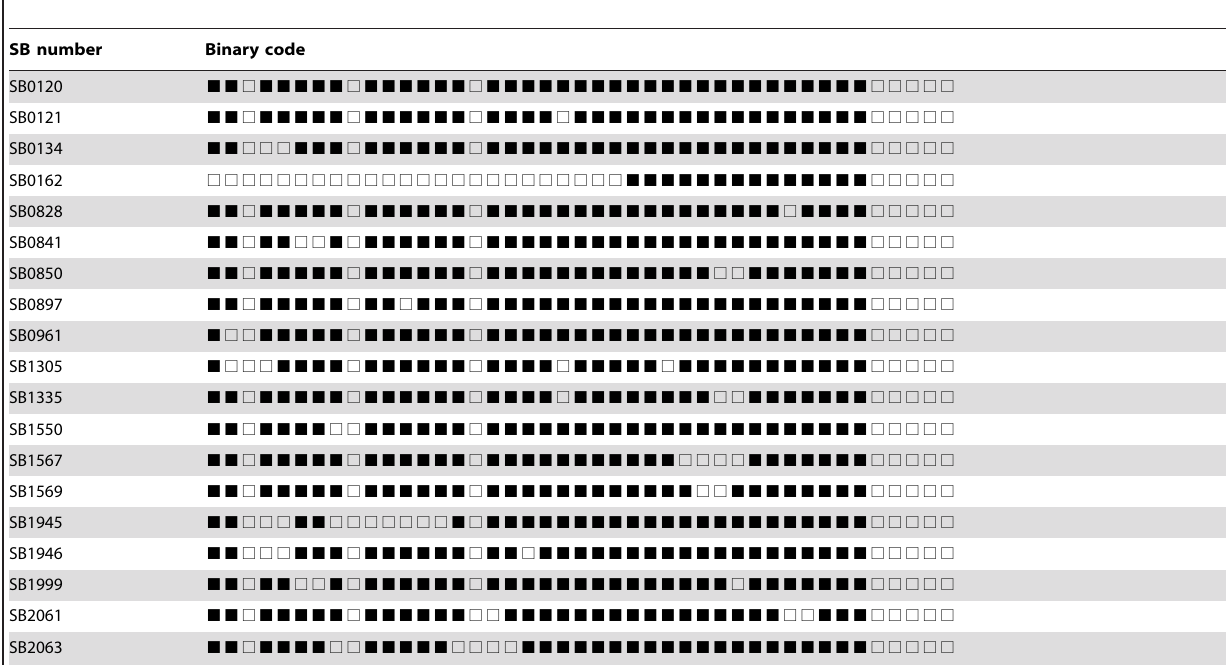
Table 3. Mycobacterium bovis spoligotype patterns identified in strains isolated from cattle from Sicily.